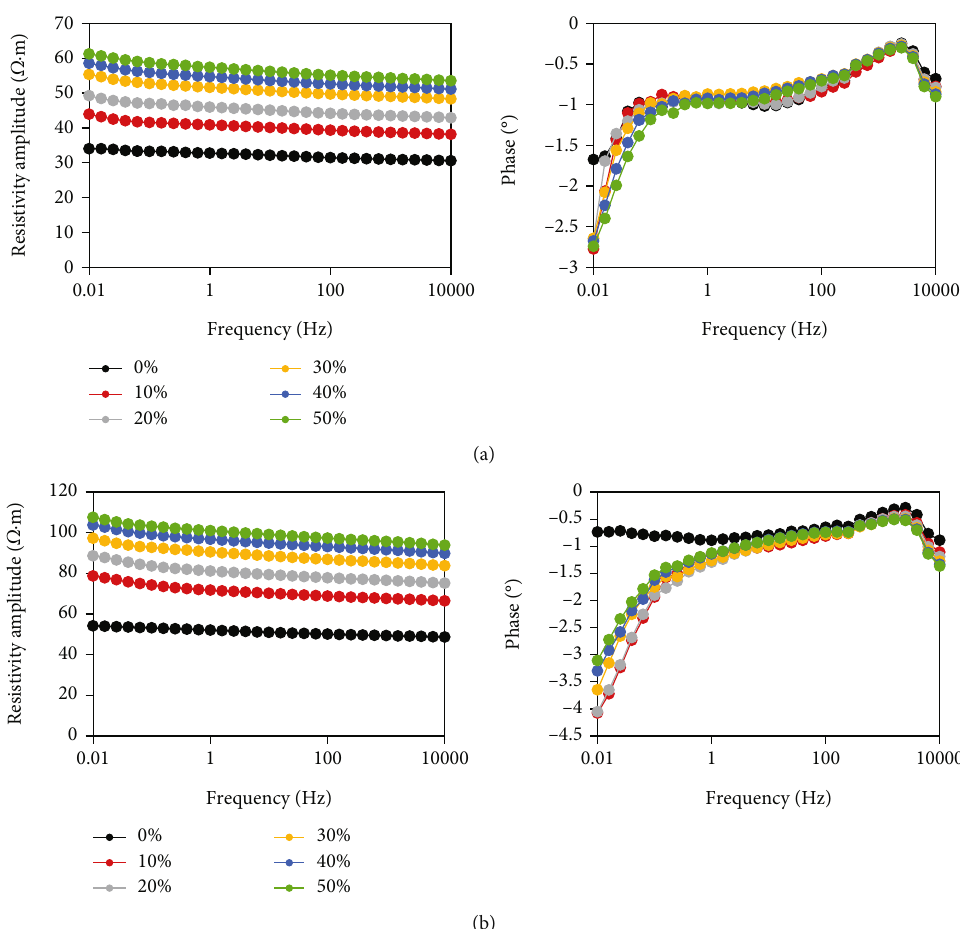
Figure 8: (a, b) The amplitude and phase curves of the complex resistivities of samples 1 and 5 under di ff erent oil saturation conditions, respectively. The left column shows the complex resistivity amplitude curves, and the right column shows the complex resistivity phase